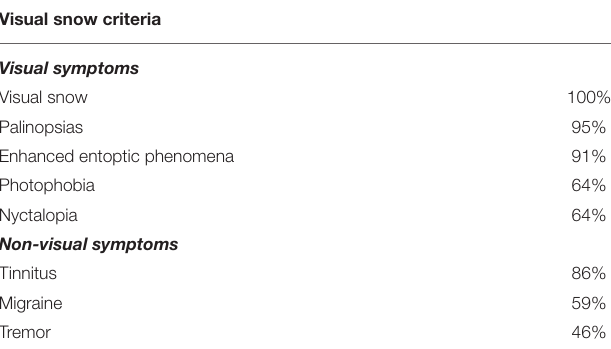
TABLE 1 | Frequency of visual and non-visual symptoms of visual snow participants in line with diagnostic criteria. Visual snow